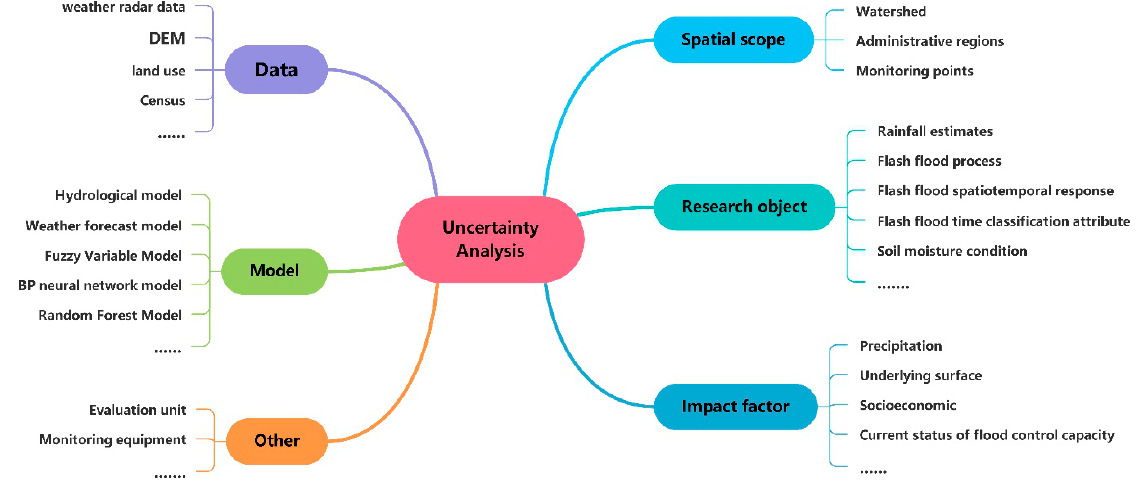
Figure 17. Uncertainty analysis chart (drawn by Edraw MindMaster).